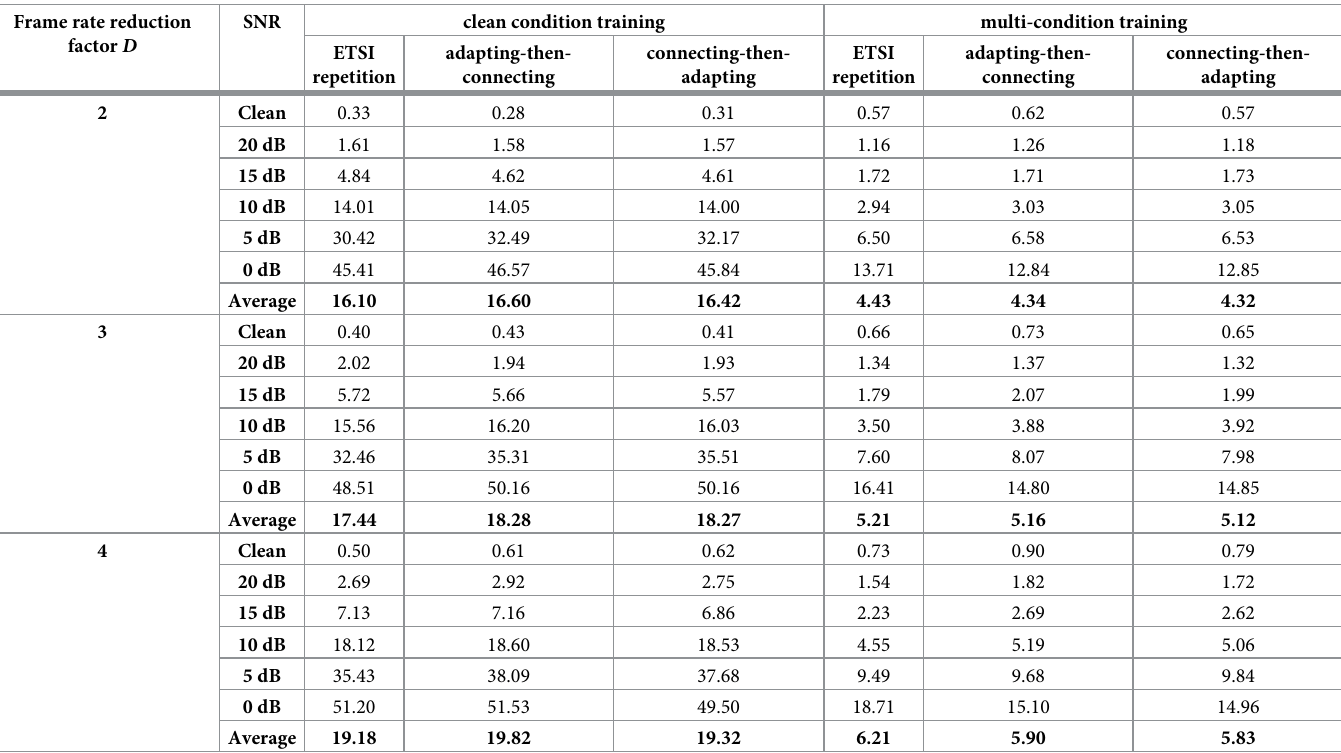
Table 4. Substitution error rate for the ETSI repetition and the two adaptation